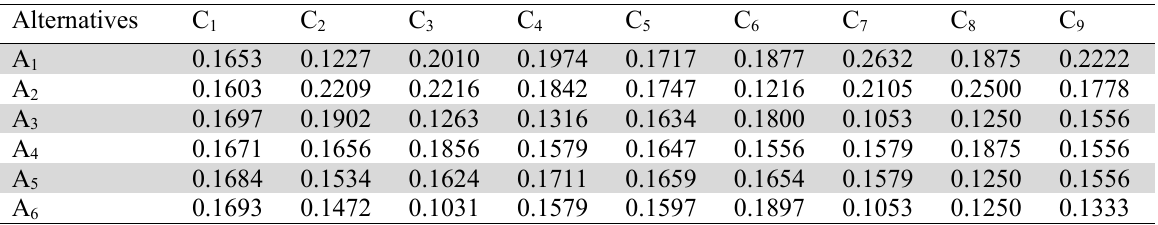
Normalized decision matrix